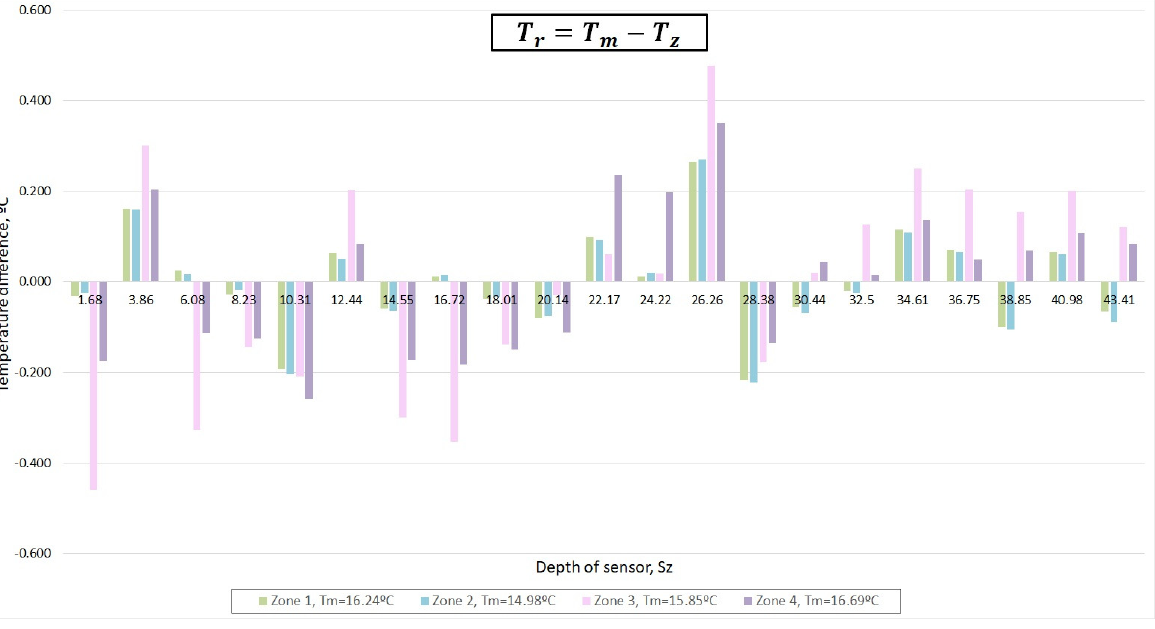
deviation trend from the mean.